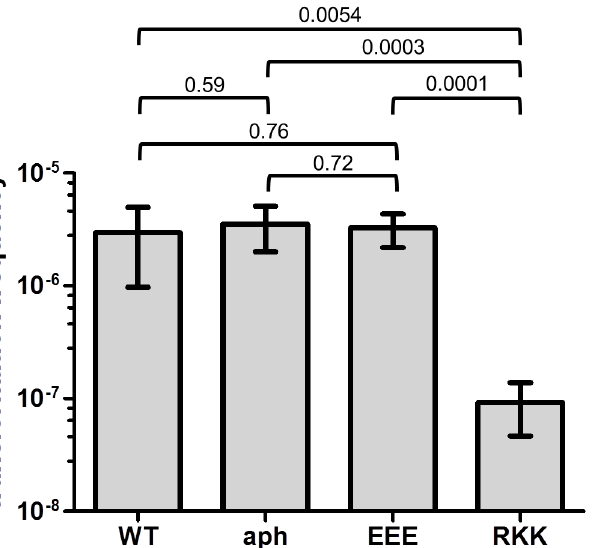
Fig 7. Transformation of Neisseria meningitidis expressing PilG variants with altered DNA binding activity. Strain MC58 (WT), MC58-pilG:aph (aph), MC58-pilG-EEE:aph (EEE), and MC58-pilG-RKK:aph (RKK) were used. The strains were quantitatively tested for competence in DNA transformation in six independent experiments. The p values determined by t-test are indicated on the brackets.